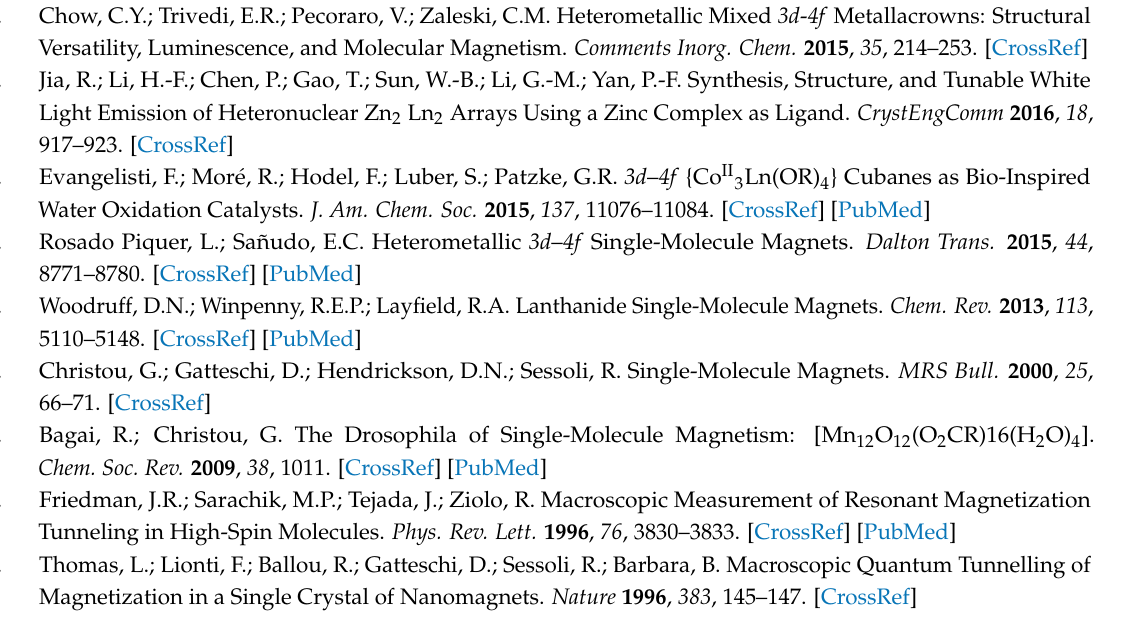
complex 2 , Figure S2: Labeled schematic representation of the core {Mn 4III Ln III ( µ -NO) 4 } 11+ of complex 2 . Color scheme: Tb, yellow; Mn III , blue; N, green; O, red, Figure S3: Crystal packing representation in complex 2 , Figure S4: IR spectrum for complex 1 , Figure S5: IR spectrum for complex 2 , Figure S6: IR spectrum for complex 3 , Figure S7: UV–Vis spectra of 1 (black), 2 (red), 3 (blue), and shiH 3 (green) in MeCN, Figure S8: M vs. H plots for complex 1 in various temperatures as indicated. Solid lines are guidelines for the eyes, Table S1: Crystallographic date for complexes 1 – 3 , Table S2: Selected bond Lengths for complex 2 , Table S3: Selected Bond Angles for 2 , Table S4: Shape measurements of the 8-coordinate lanthanide coordination polyhedra. The bold numbers indicate the closest polyhedron according to SHAPE